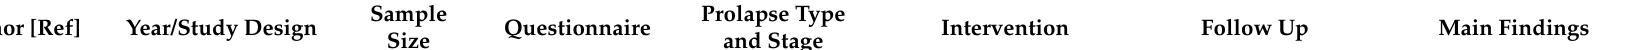
Table 2. The characteristics of the studies on the effectiveness of reconstructive vaginal surgeries by native tissue on the quality of life in women with pelvic organ